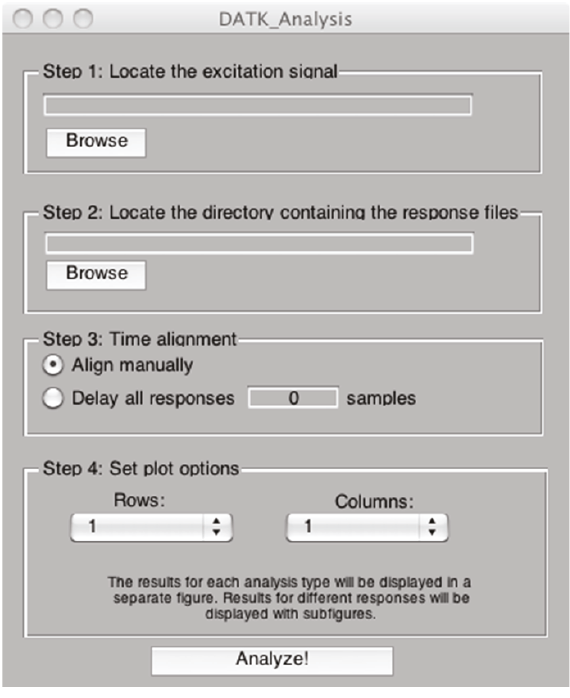
Figure 3: A dialog box for analyzing the system responses.